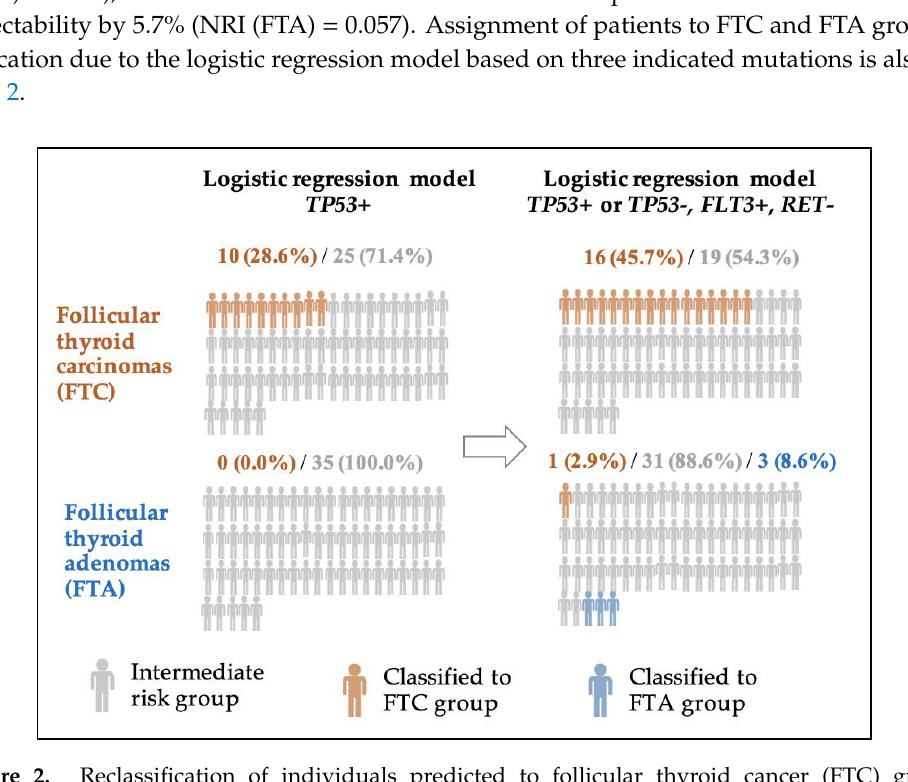
Table 4. The characteristics of patients diagnosed with follicular thyroid cancer according to their mutational status.